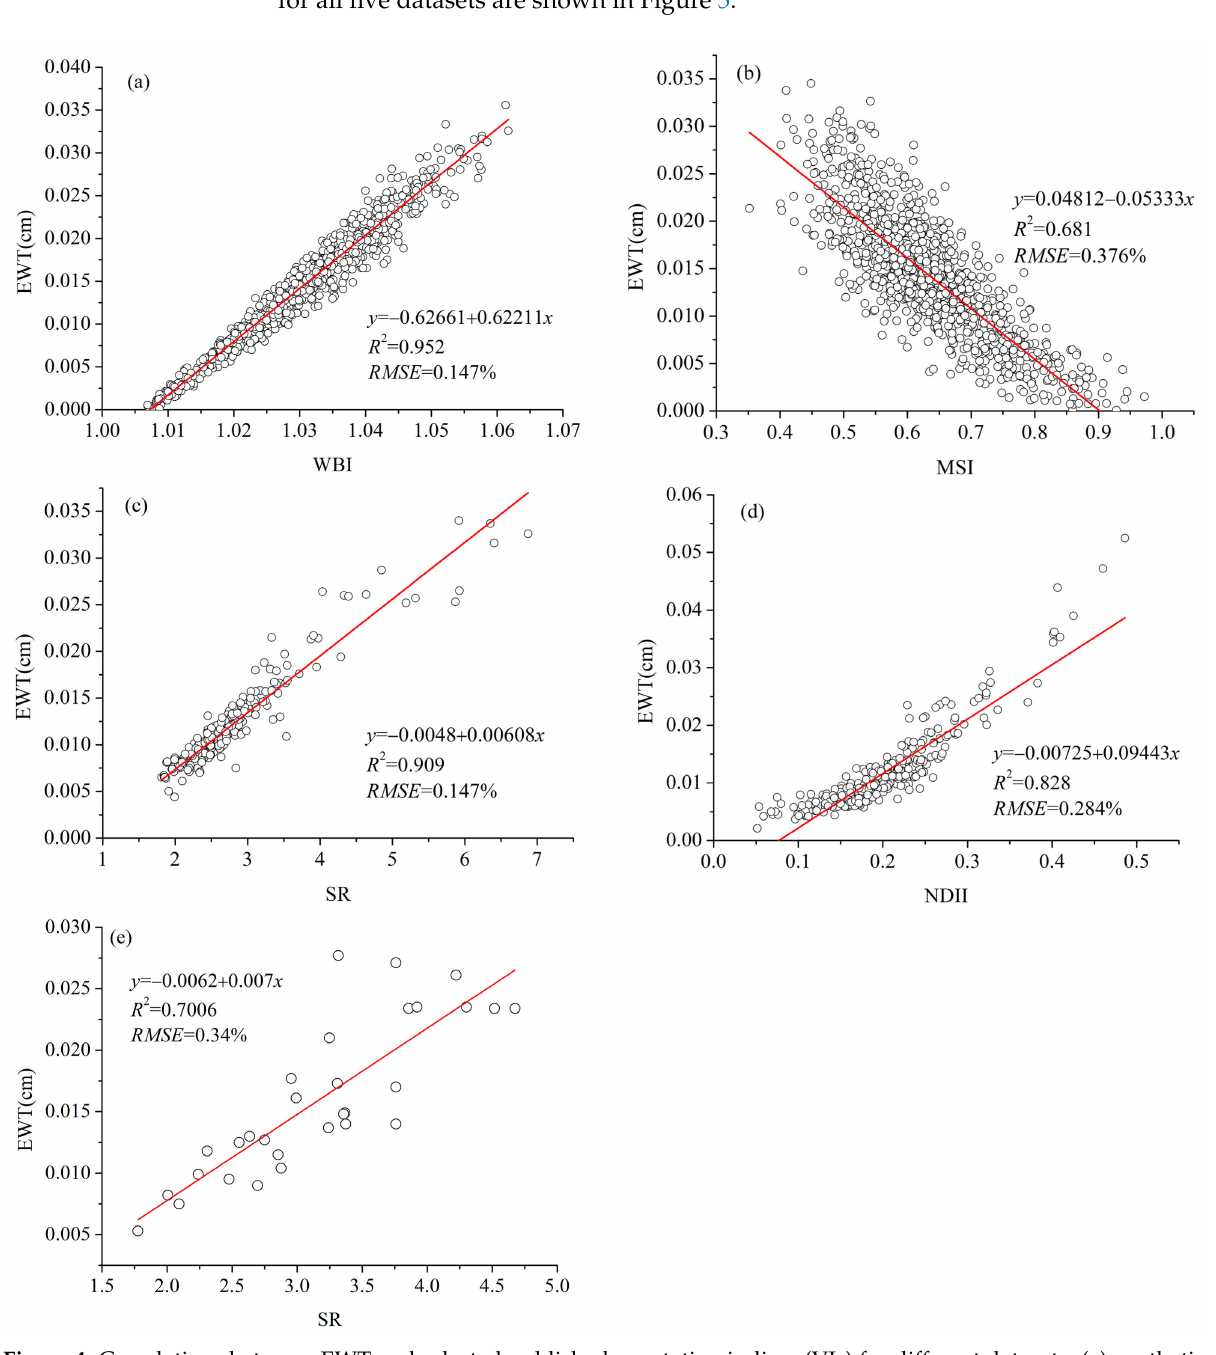
Figure 4. Correlations between EWT and selected published vegetation indices (VIs) for different datasets: ( a ) synthetic spectrum without noise, ( b ) synthetic spectrum with 2% random Gaussian noise, ( c ) ANGERS, ( d ) LOPEX, and ( e )